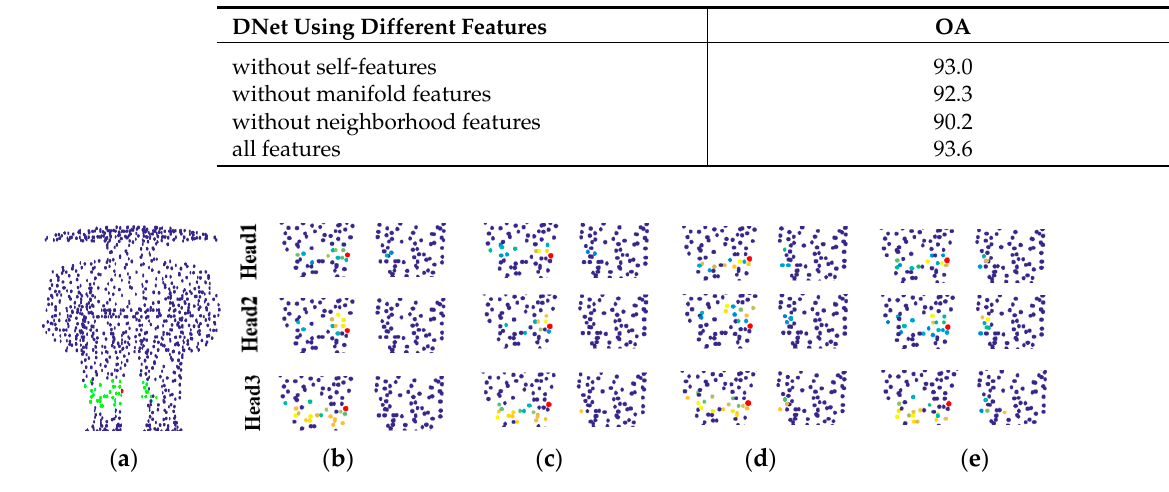
Figure 13. Neighborhood points selected by multi-head structure with different features. ( a ) Model. ( b ) All features. ( c ) Without self-features. ( d ) Without manifold features. ( e ) Without neighborhood features.